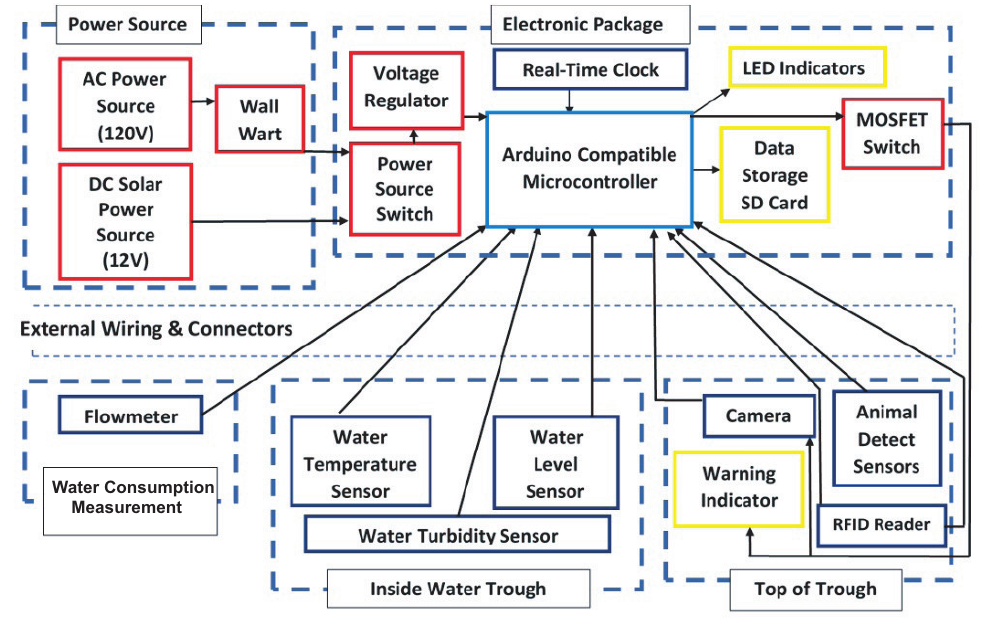
Figure 2. Hardware block diagram of the smart water intake monitoring